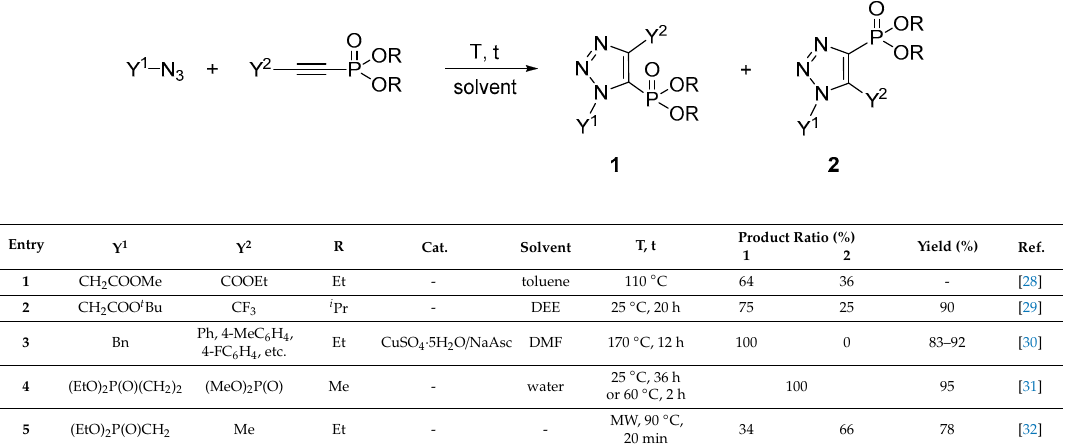
Table 1. Cycloaddition of azides and alkynyl phosphonates.